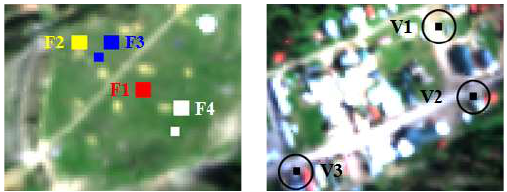
Figure 2. Zoomed views of the fabric panels ( left ) and vehicles ( right ) used as targets in the HyMap dataset. Table 1. Details of the fabric panels and vehicles used as targets in the HyMap dataset.